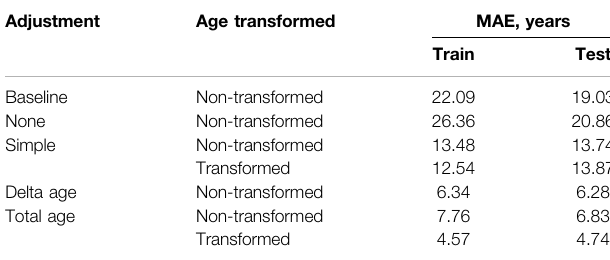
METHODS for the description of the adjustments